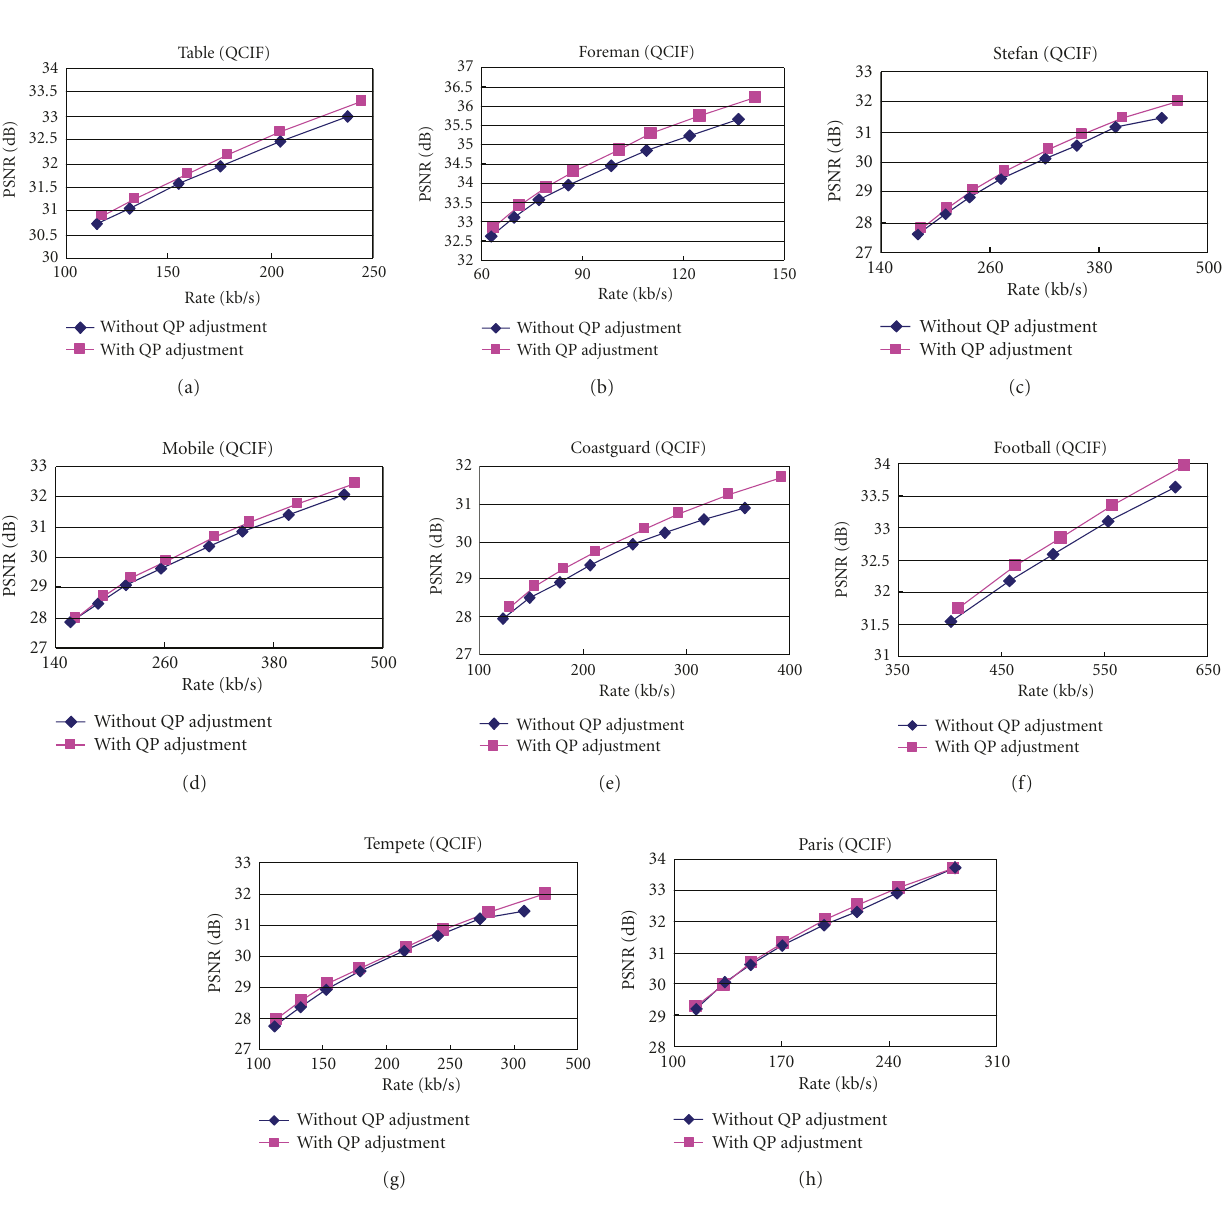
Figure 7: Transcoding performance comparison between with and without QP